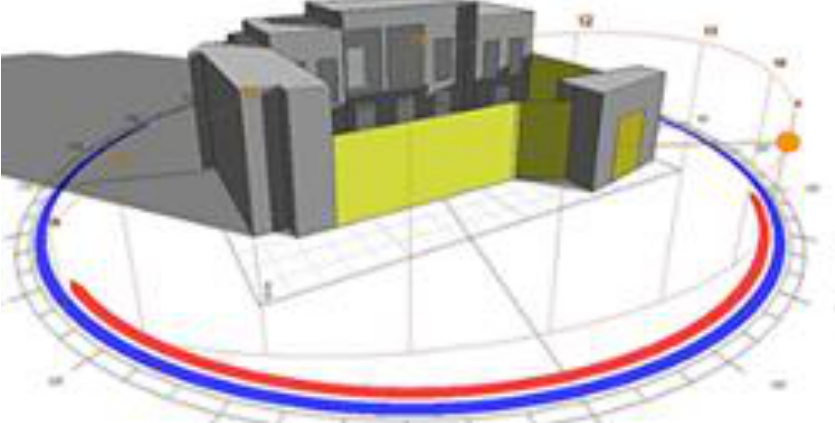
Figure 18 3D view of house No.4 (January, 8:00 am)